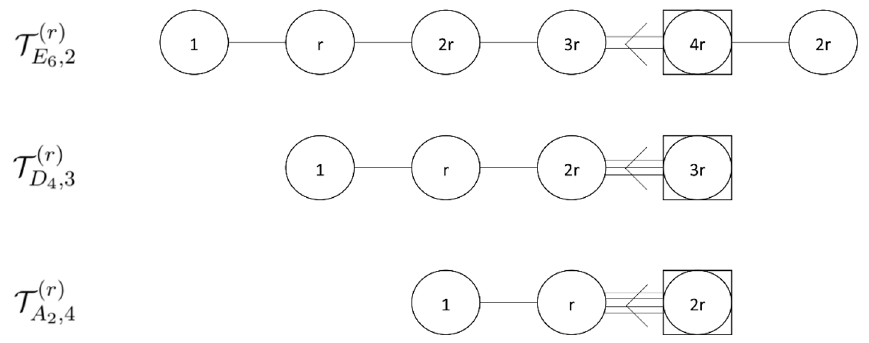
Figure 8. The magnetic quivers for some of the T -theories. Here the square surrounding one of the nodes represents the node where the ungauging is